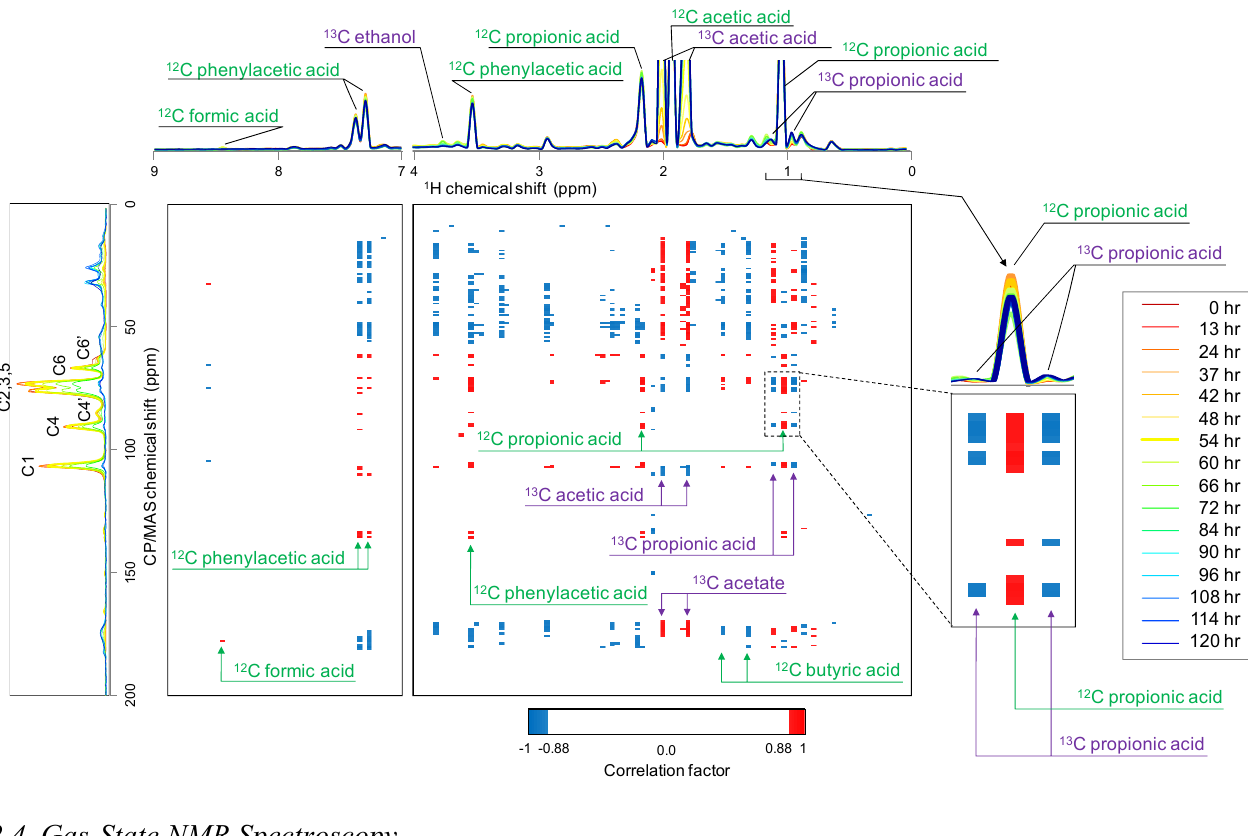
Figure 3. Heat maps comparing solid-state 13 C-CP/MAS and solution-state 1 H-NMR spectra. Sampling time is indicated by the colored lines described in the figure. The threshold value of the correlation coefficient was set to a cutoff value of 0.88 as the absolute value in the correlation heat map. Red and blue denote positive and negative correlations,